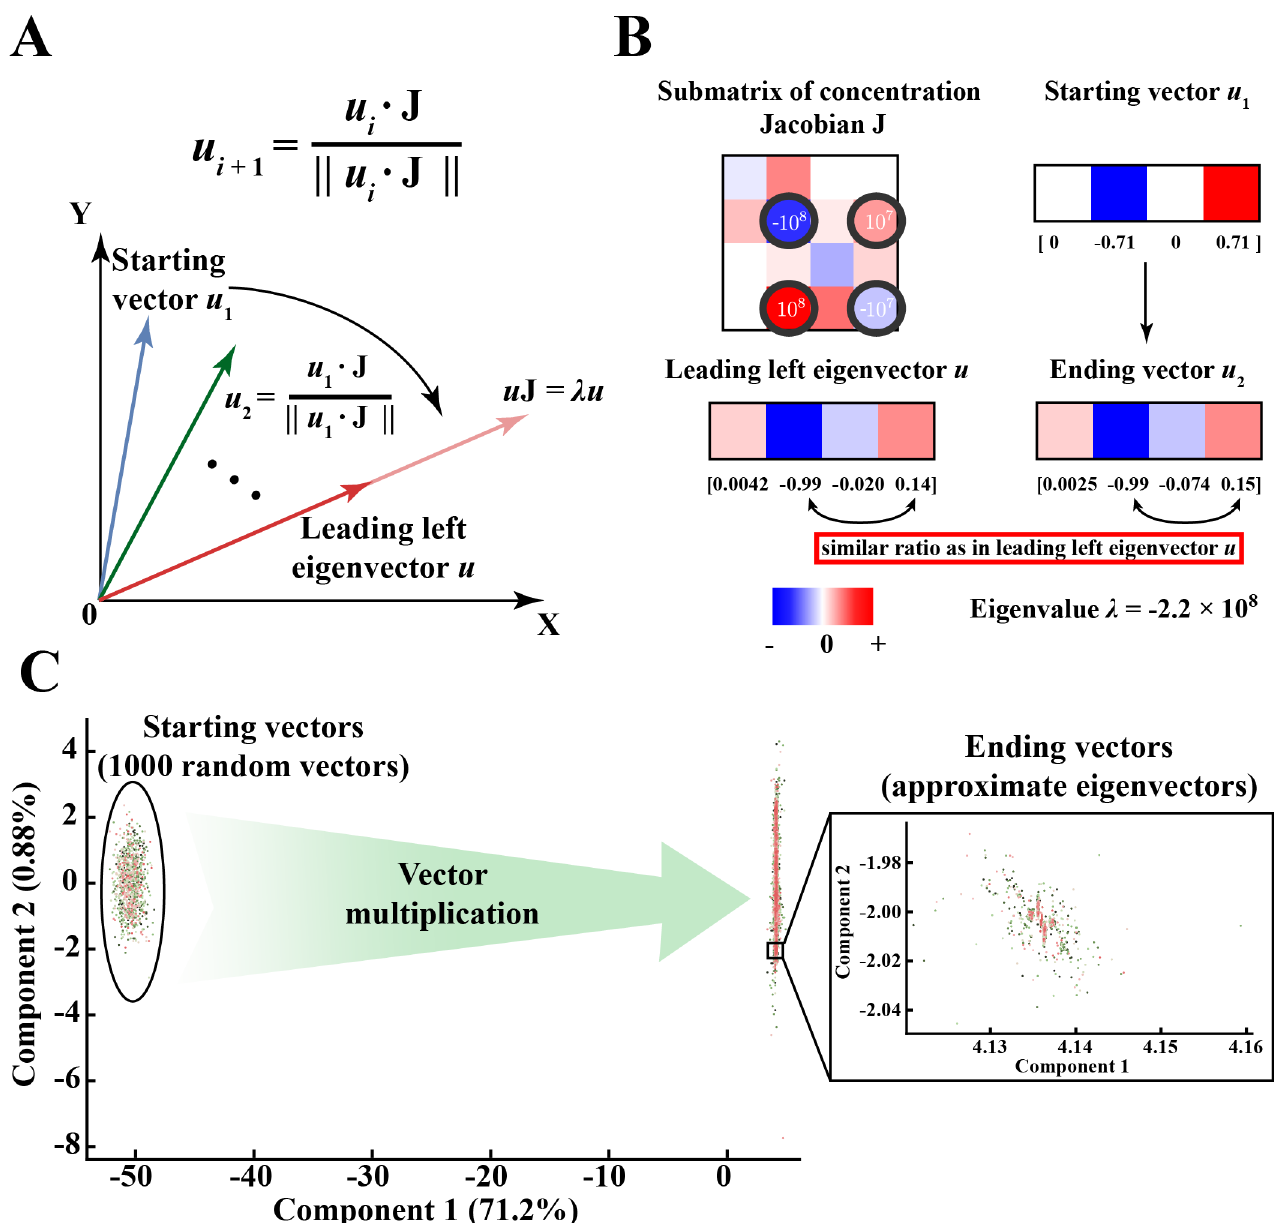
Fig 3. The power iteration algorithm demonstrates how complicated dynamic structuresarise from topologically connected elements of similar magnitude within the Jacobian matrix. (A) Power iteration can be used to calculatethe dominant left eigenvector of the Jacobianmatrix. The left eigenvectors are the modes of the metabolicnetwork. The algorithmleft multiplies the Jacobianmatrix by a randomvector ( u i ), normalizes the resultingvector and repeats the process until the vector converges to the eigenvector. (B) Topologically connectedJacobianelementsof similar magnitude determinecomplicated eigenvector structure. In this case study, we extracted a submatrix of J that corresponds to the nonzeroelements of a certain eigenvector, which contains G6PDH enzyme forms. The four Jacobianelements(also the largest) that are key in determining this eigenvector structure are locatedin the 2 nd and 4 th rows, circled in black. Specifically, the structure of 2 nd or 4 th rows matches closely with that of the eigenvector, with similar ratios at the 2 nd and 4 th positions.Multiplyingthe Jacobianmatrix by any non-orthogonal starting vector ( u 1 ), for example the one shown, results in a vector ( u 2 ) that has a structure more similar to the eigenvector. The contributionof those rows individuallyto eigenvector formation are further shown in Fig 4 and S4 Fig. For clear demonstration purposes, the comparison of relative colors only works for individual box (surrounded by black stroke) itself, but not across different boxes. (C) Principalcomponentanalysison all power iteration vectors starting with 1000 different randomvectors. We randomly picked 1000 starting vectors and multipliedthem with the full Jacobianmatrix (292 × 292). The starting vector is multipliedthrough several iterations(10 ~ 20) until it converges to the eigenvector (the dot product of the endingvector and the eigenvector is no greater than 1.0001and no less than 0.9999). We then performed principalcomponentanalysison all iteration vectors (includingthe starting vectors) and plotted each vector in terms of the contributionfrom the first two principalcomponents. The first principal